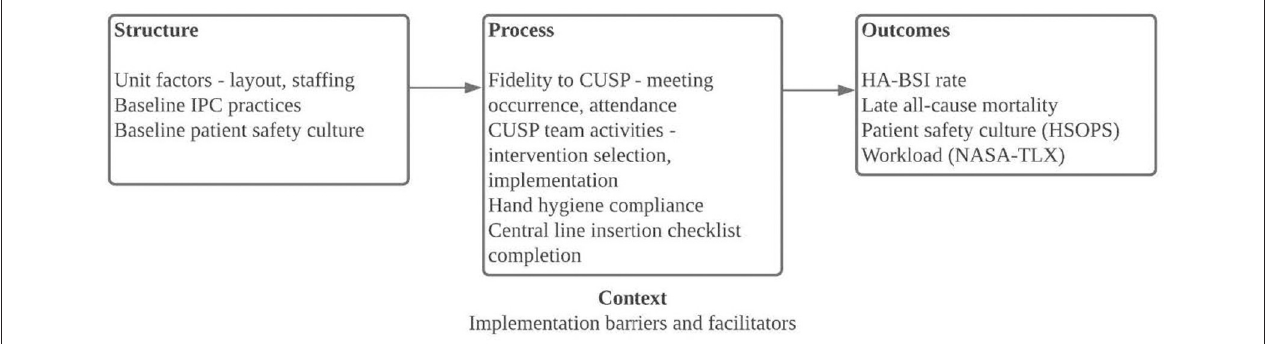
FIGURE 1 | Conceptual framework for CUSP implementation at four tertiary care neonatal intensive care units in Pune, India. CUSP, Comprehensive Unit-based Safety Program; HA-BSI, healthcare-associated bloodstream infections; HSOPS, Hospital Survey on Patient Safety Culture; IPC, infection prevention and control; NASA-TLX, National Aeronautics and Space Administration Task Load